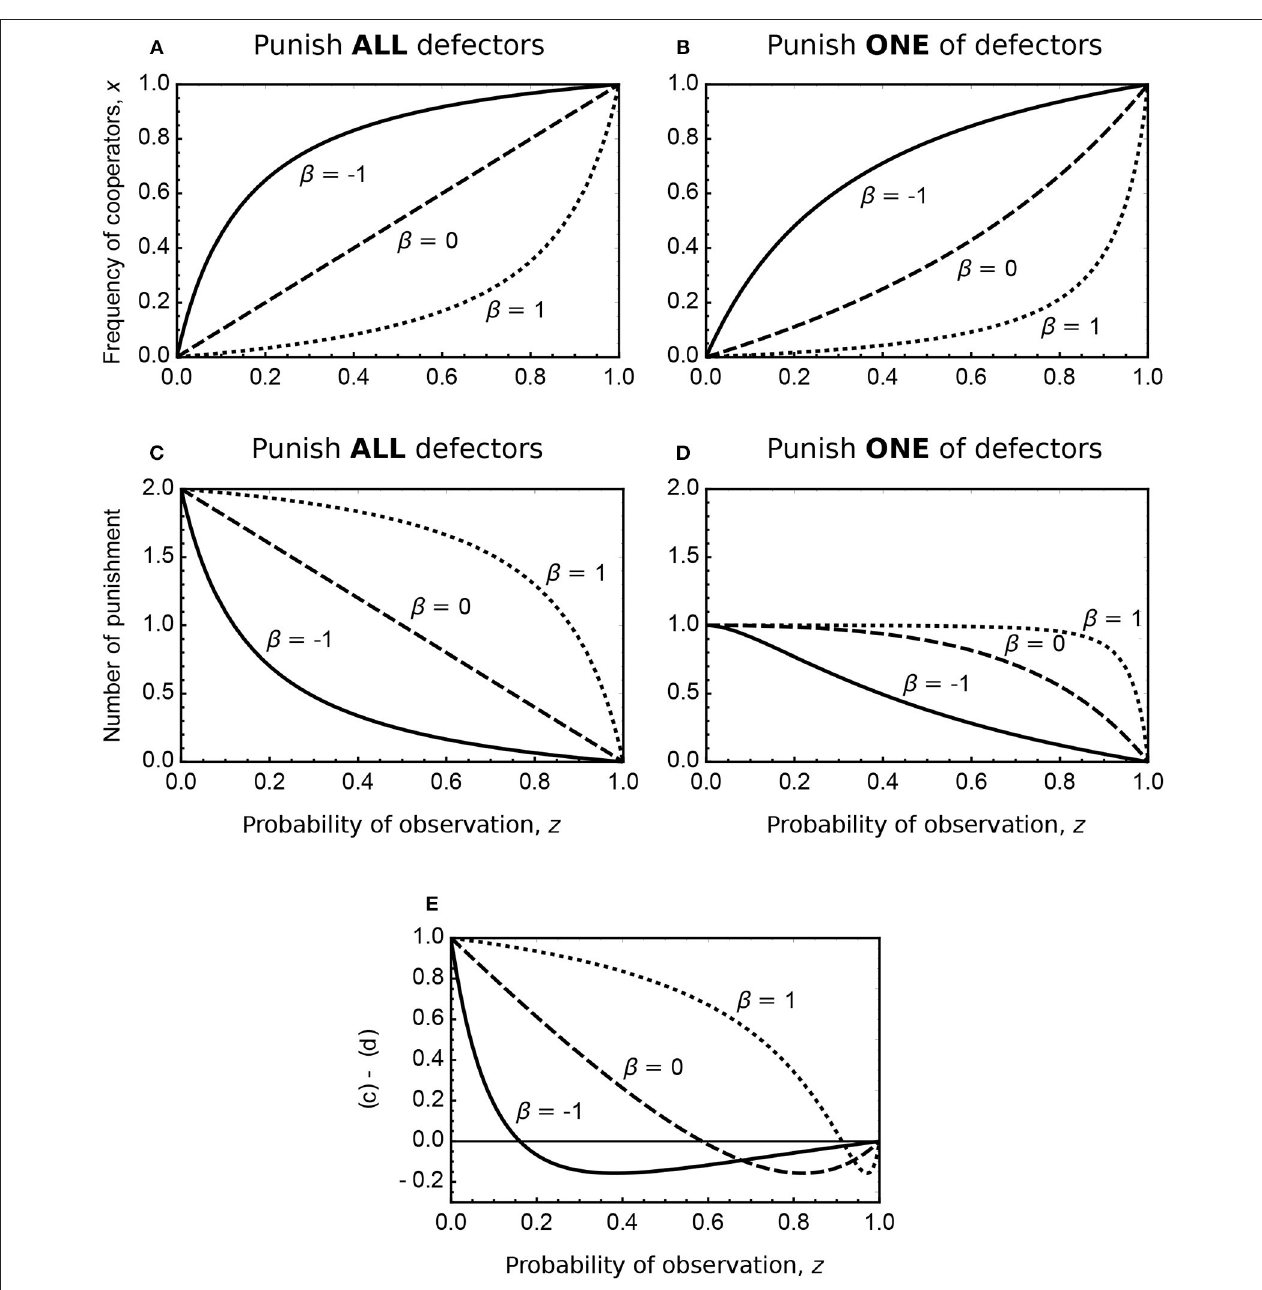
FIGURE 3 | Stable frequency of cooperators (A,B) and the expected number of punishment per observation (C,D) in a dimorphic population of cooperators and defectors if Equations (2) or (6) is violated. (A,C) The ALL variant. (b, d) The ONE variant. (E) Shows the difference between (C,D) . Individuals are risk newtral (dashed line; β = 0), risk averse (solid line; β = − 1), or risk prone (dotted line; β = 1). Parameters: T = 2 and F = 1.